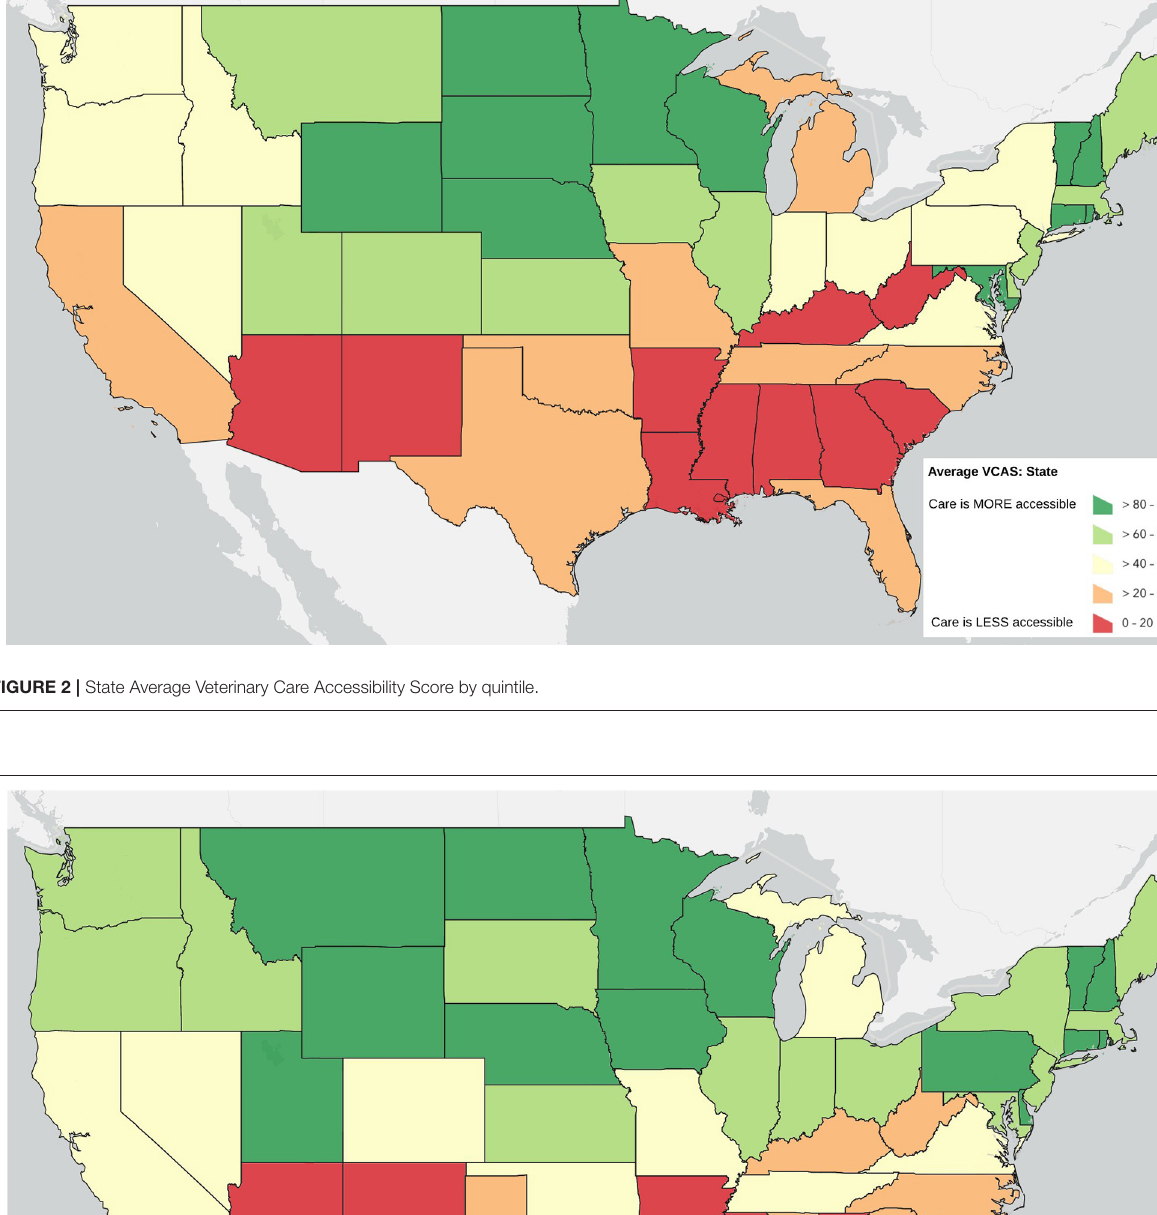
Frontiers in Veterinary Science |